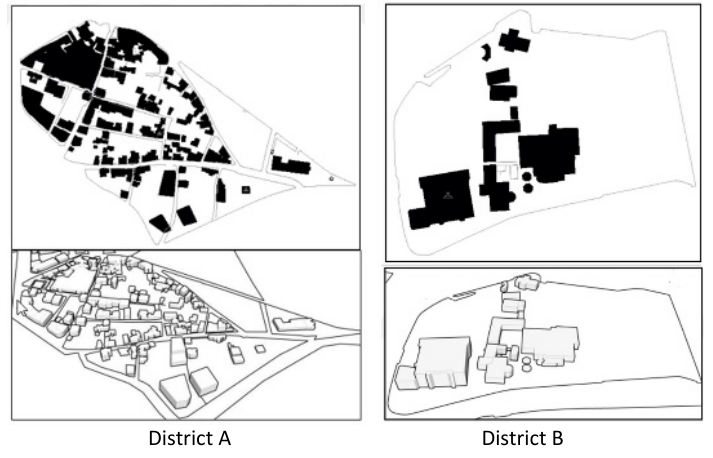
District A District